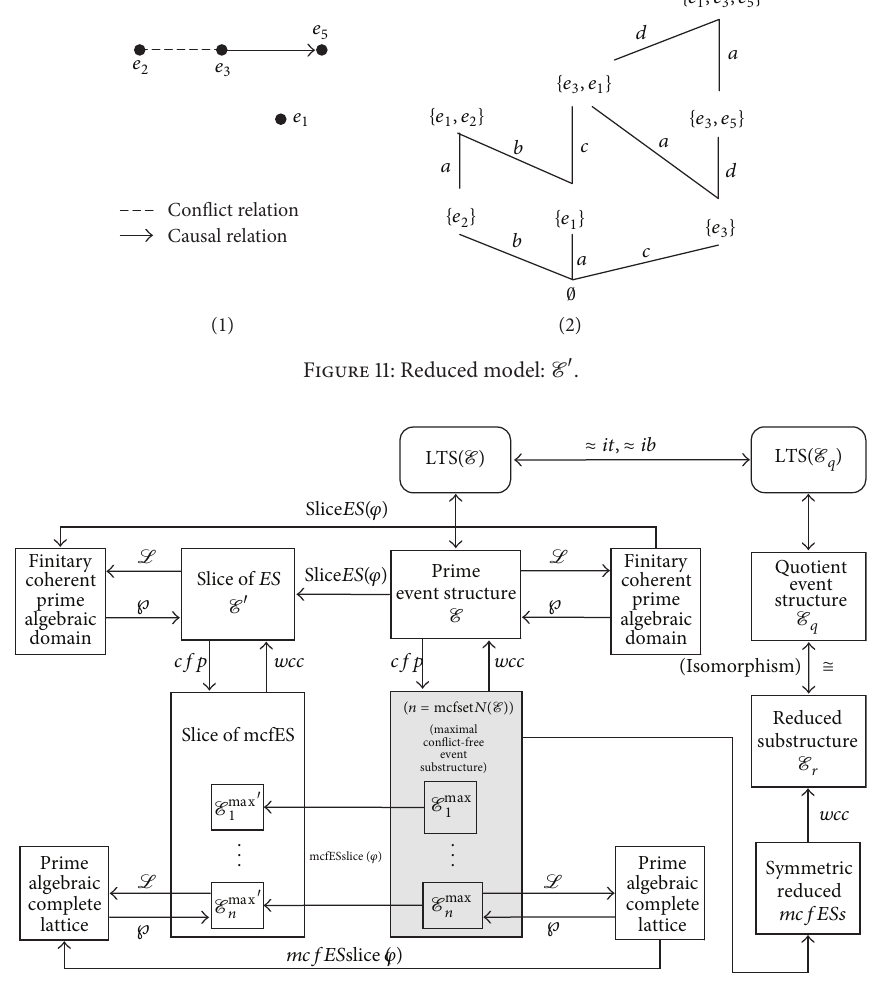
Figure 12: Unified mathematical